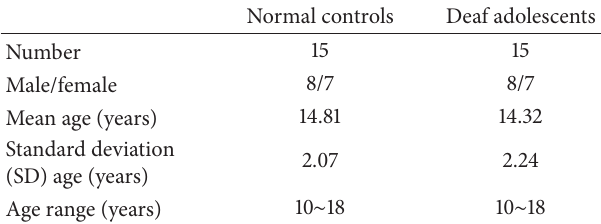
Table 1: Biographical information of two